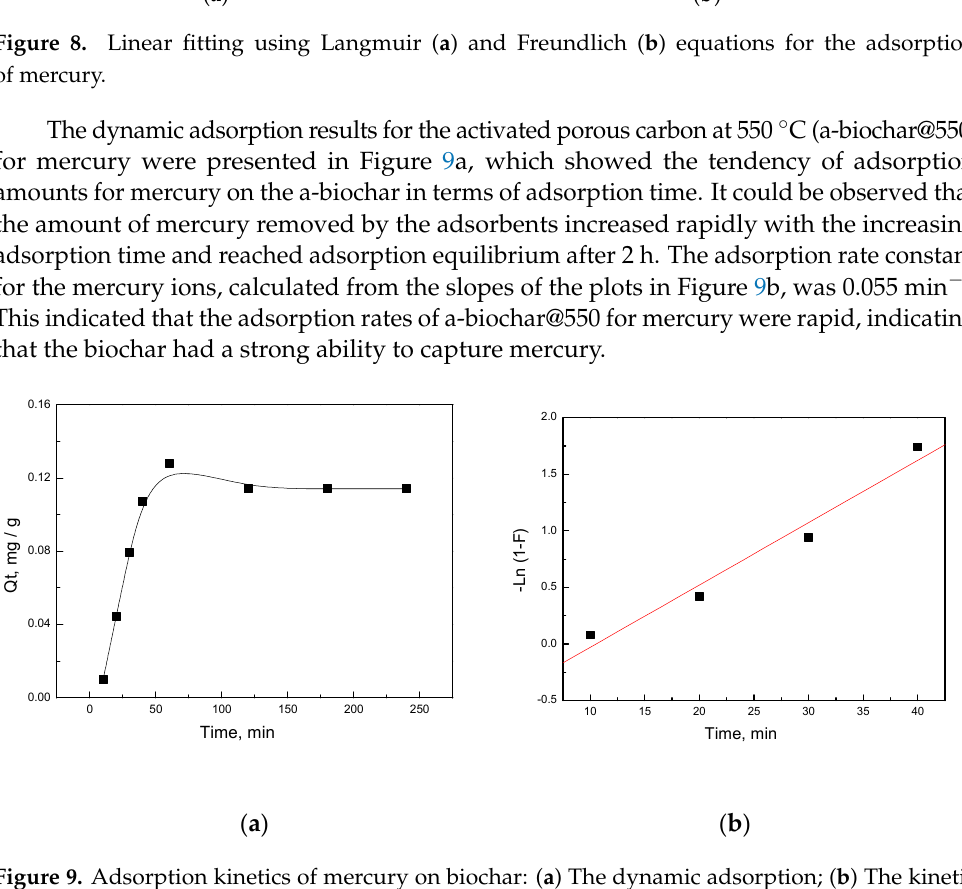
Figure 8. Linear fitting using Langmuir ( a ) and Freundlich ( b ) equations for the adsorption of mer-